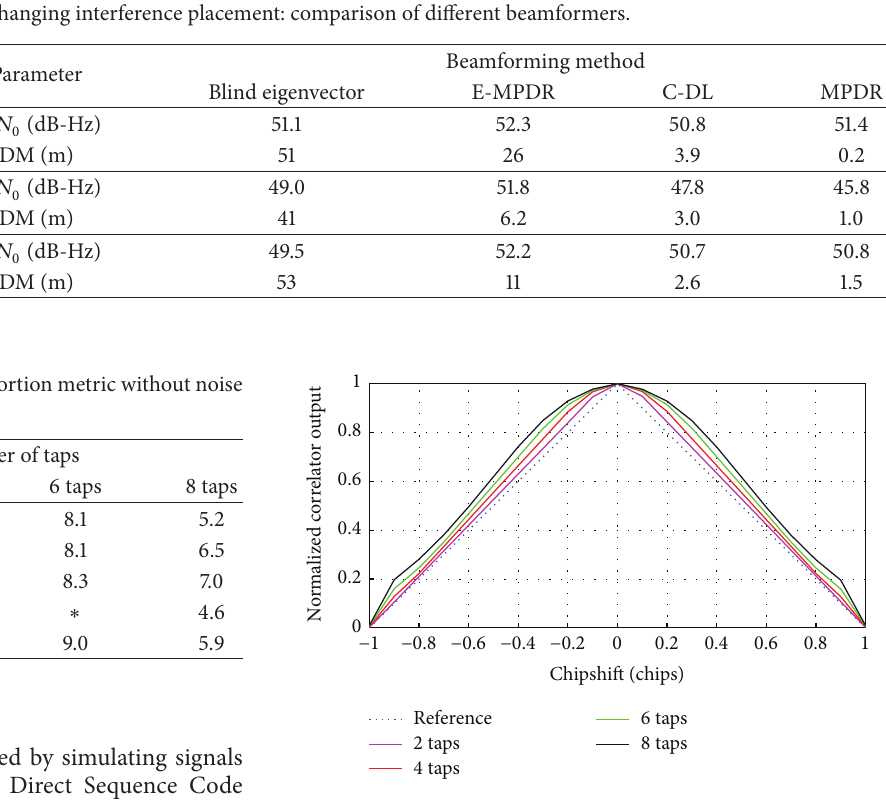
Figure 6: CCF distortions for PRN10—Scenario